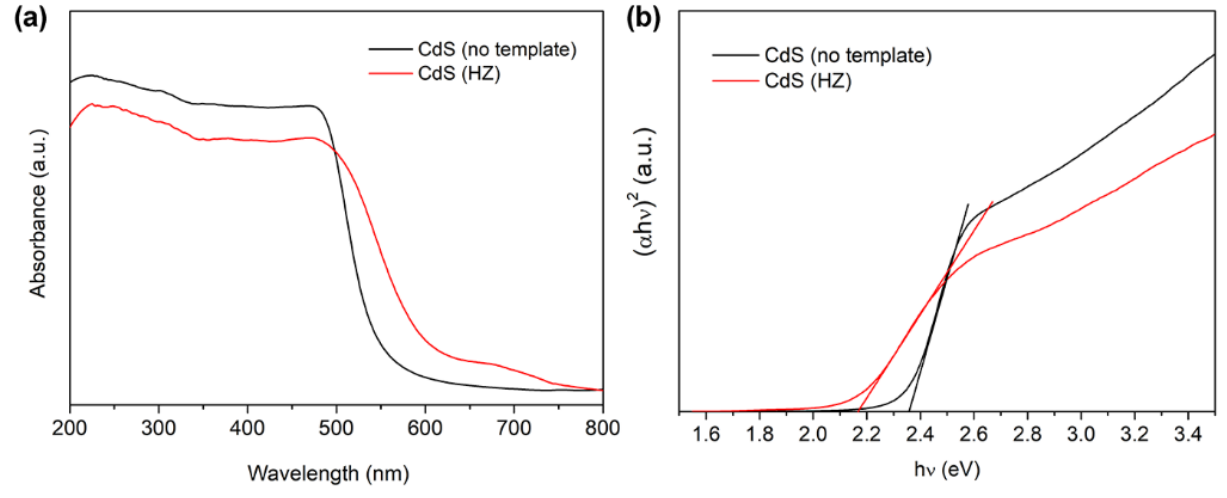
Figure 4. ( a ) UV-Vis DRS spectra and ( b ) energy band gap determination of CdS(HZ) and CdS synthesized without template.